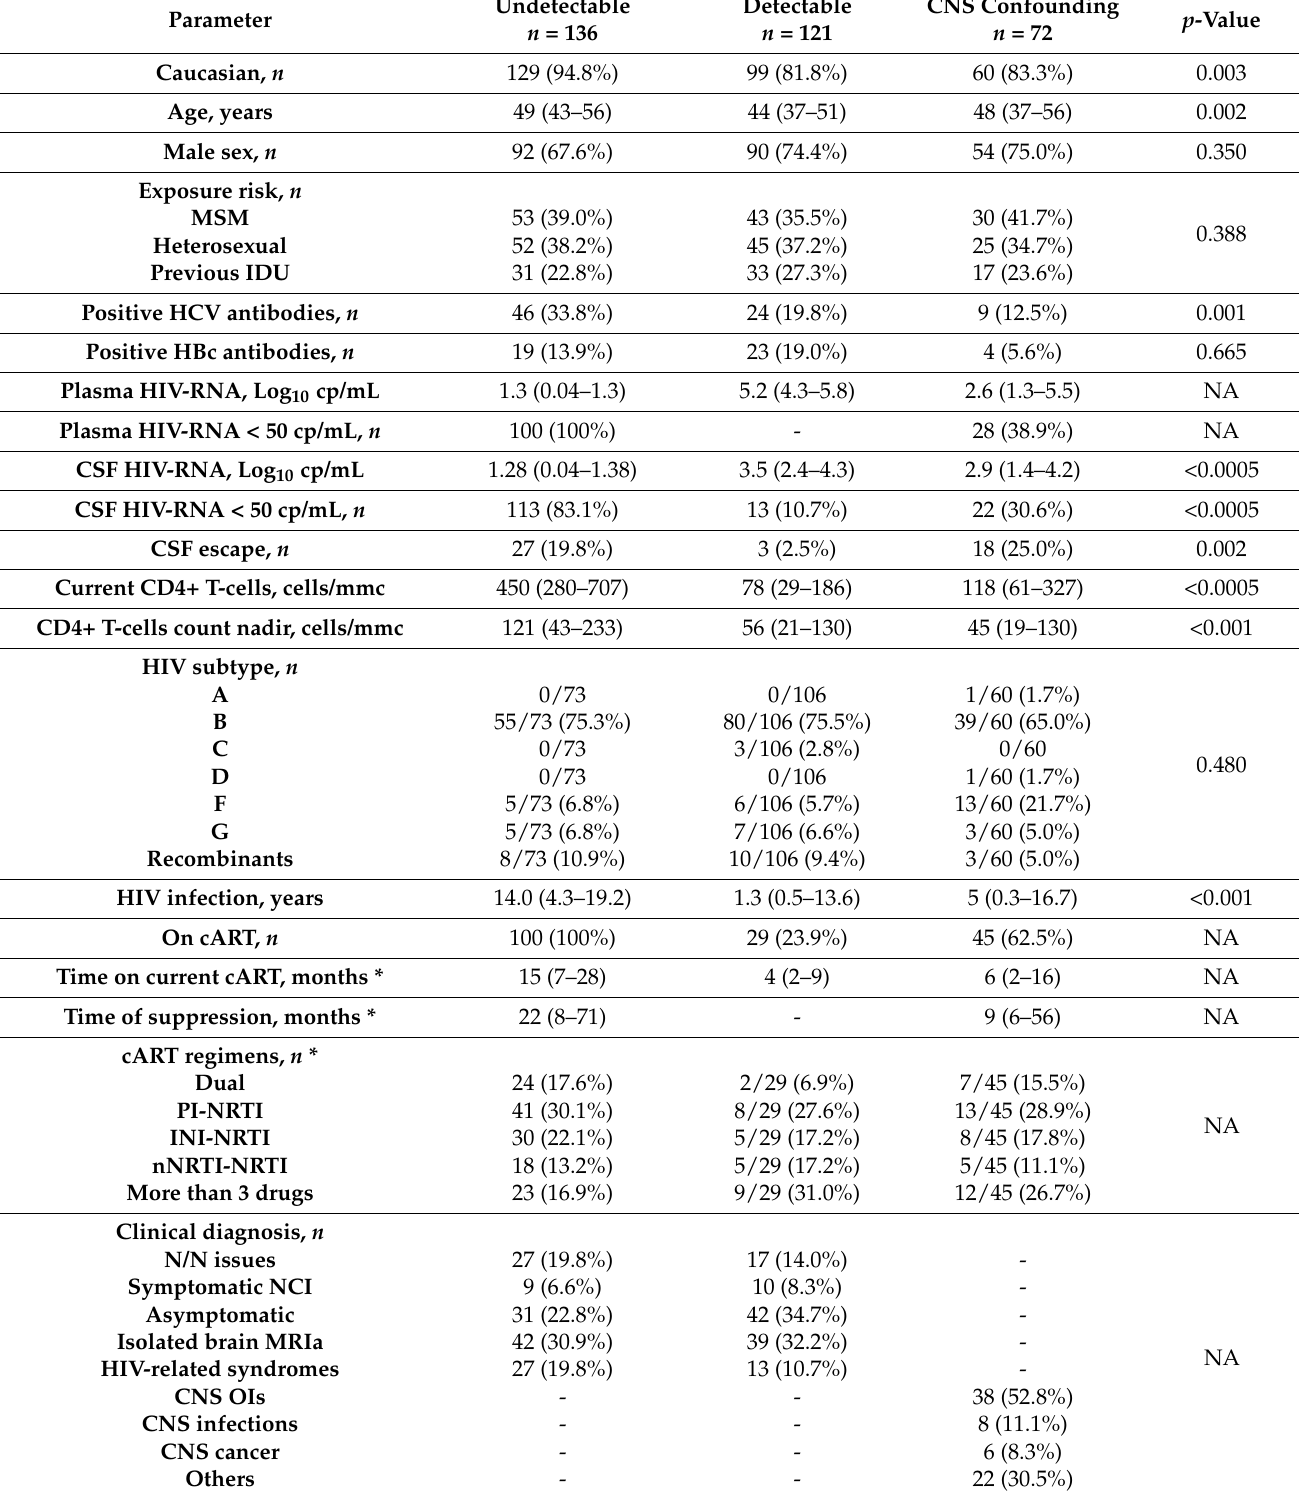
Table 1. Demographic, clinical, and viro-immunological characteristics of the study